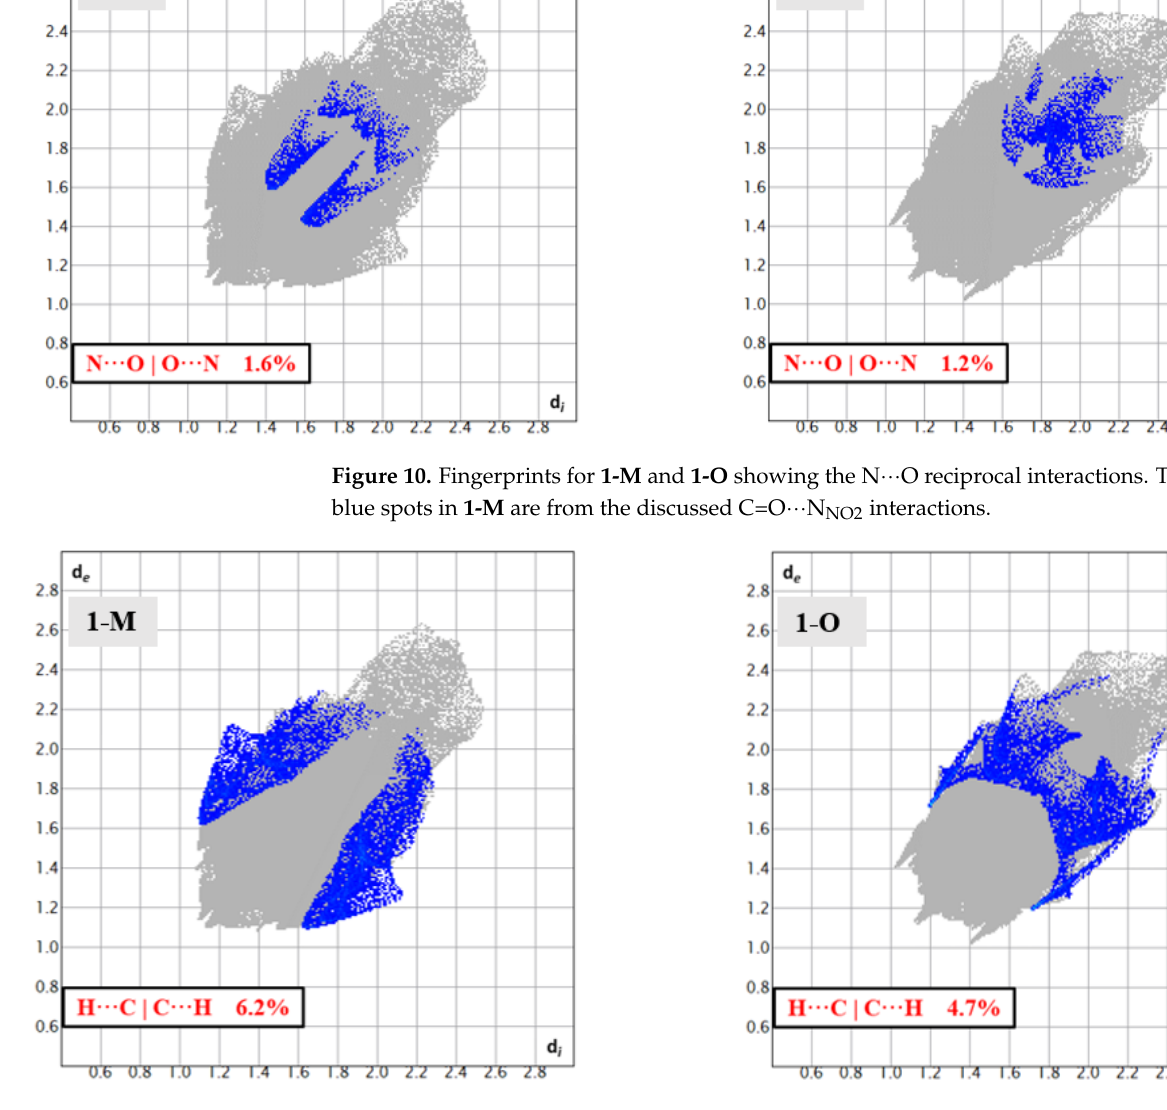
Figure 11. Fingerprints for 1-M and 1-O showing the H···C reciprocal interactions. For 1-M , C11 also interacted with the benzoxadiazole oxygen O1 at a distance of 3.3626(14) Å ( d (C11···O1 l , l = 1 − x, −1 /2 + y, 1/2 − z)), albeit at a longer distance than previ-